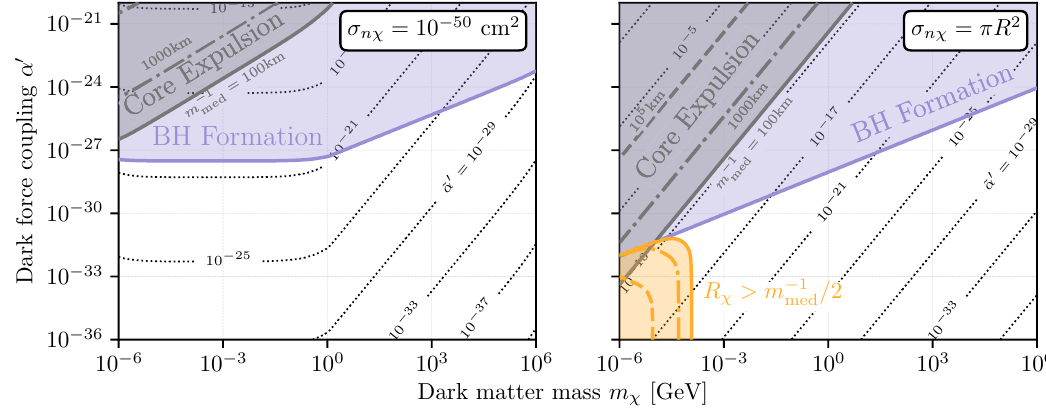
Figure 6 . Constraints on an attractive dark force from a binary neutron star system as a function of the DM mass m (cid:31) and the dark (cid:12)ne structure constant (cid:11) 0 . The dotted contours show the value of e (cid:11) 0 (in the case of neutron stars with equal dark charge-over-mass ratio) or e (cid:12) 0 (for the case that only one neutron star carries a dark charge, see eq. (2.2)) at each point in the plot. In the purple region, the dark force induces collapse of the neutron stars’ dark cores to black holes, assuming the amount of DM inside the stars is determined by DM capture from the halo, see appendix A. Inside the gray shaded region, the dark cores are expelled from the neutron stars as soon as the screening of the force is lifted. We show this region for m (cid:0) 1 = 100 km (solid), 1000 km (dot-dashed), and 1 (cid:2) 10 5 km. med Within the yellow regions, where R (cid:31) (cid:21) m (cid:0) 1 = 2, the DM particles would be stripped away from their med host neutron star before they can have a signi(cid:12)cant impact on the inspiral. The benchmark values of m (cid:0) 1 are the same as for the DM expulsion bound. The neutron star parameters are chosen in med accordance with table 1, and without loss of generality we have chosen q (cid:31) = 1. We have assumed